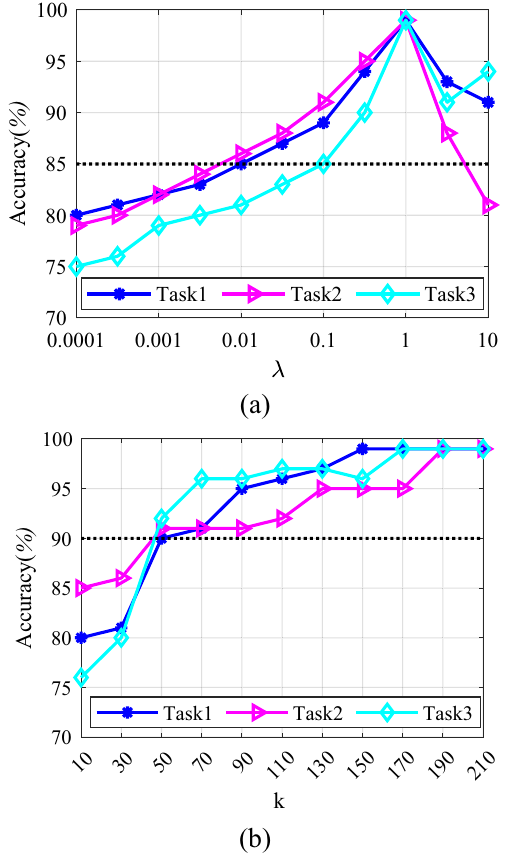
Figure 8. The parameter sensitivity of MKJDA: ( a ) regularization parameter λ; ( b ) subspace bases k.